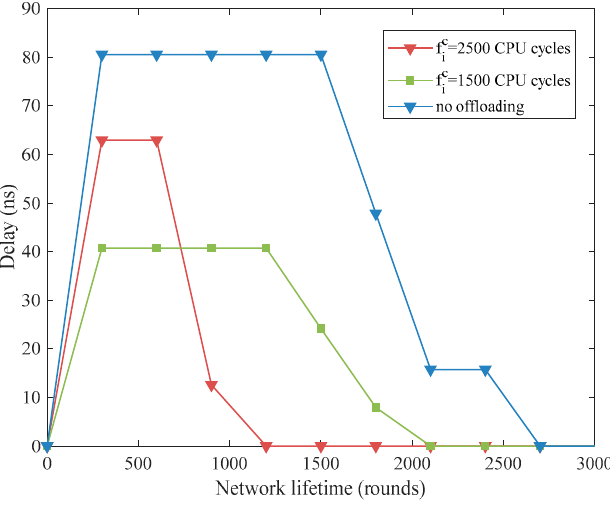
Figure 7. The overall delay under different scenarios.